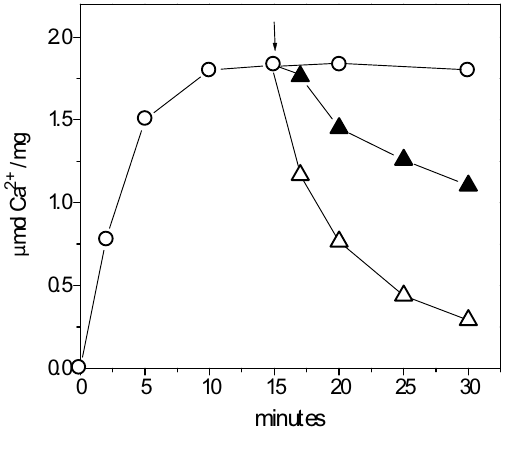
Fig. 5 – Ca 2 + release from skeletal muscle vesicles. The assay medium composition was 50 mM MOPS/Tris pH 7.0, 2 mM MgCl CaCl P i . Thereactionwas 2 ,1mMATP,0.1mM 2 ,20mM started by the addition of vesicles at 35 ◦ C. ( ❍ ) control without additions. Thearrowindicatestheadditionofeither5mMEGTA ( (cid:5) ) or 5 mM EGTA plus 1 M thapsigargin ( (cid:5)